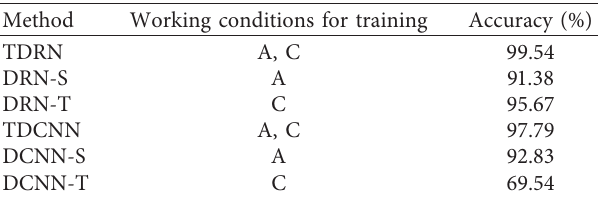
Table 3: Testing results of different methods for transfer task A ⟶